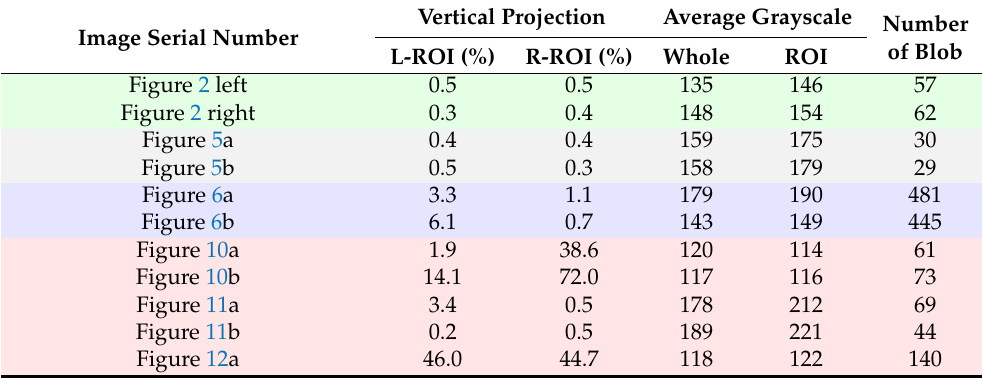
Figure 14b Table 3. Comprehensive evaluation of the images presented in this article